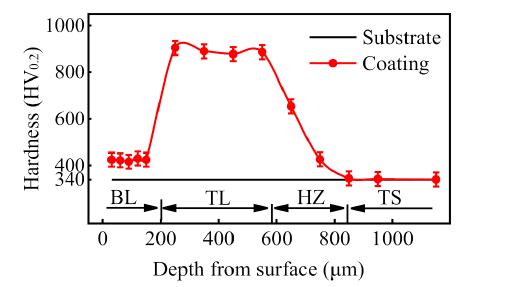
Figure 14. Microhardness distribution diagram of coating section along depth